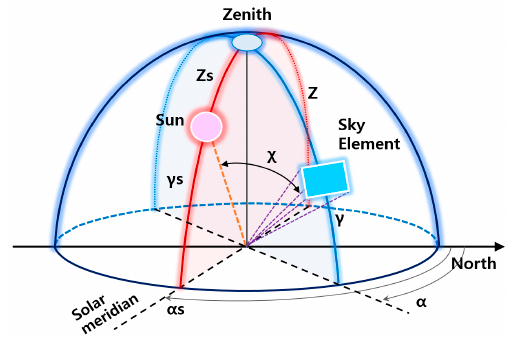
Figure 2. Diagram showing the position of the sun and sky element.